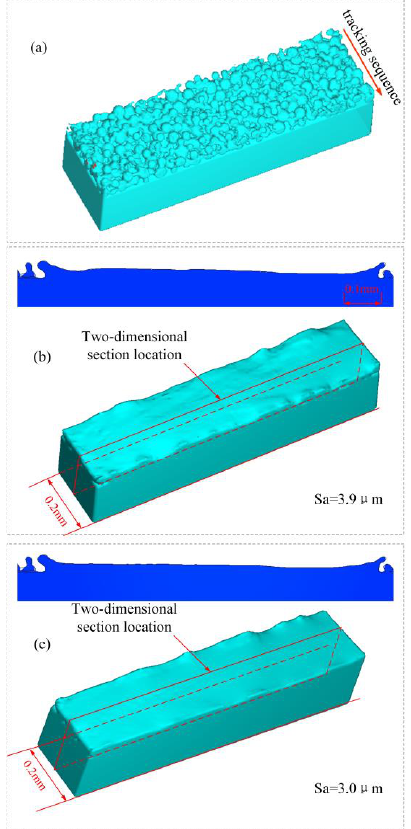
Figure 16. Multi-track simulation surface profile. ( a ) Powder bed; ( b ) As-SLMed; ( c ) ILPed. The parameters of SLM were 150 W, 0.8 m/s and 0.05 mm. The parameters of ILP were 90 W, 0.8 m/s and 0.05 mm. The hatch spacing was 0.01 mm. The length of the plane domain is 1 mm, and the height is 0.15 mm. The size of the 3D domain is 1 mm × 0.2 mm × 0.2